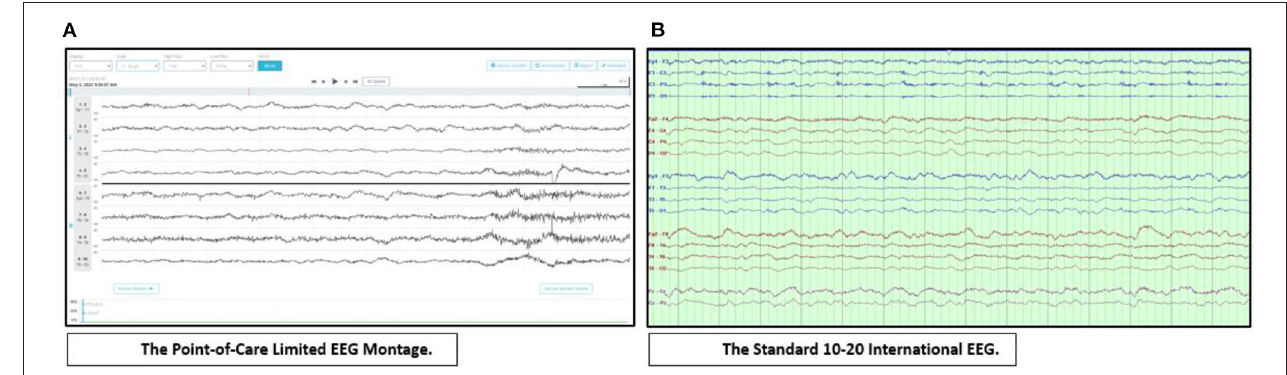
FIGURE 1 | Point-of-care EEG. Suspected seizures in a 62-year-old man with decreased level of consciousness ruled out within 10min with the use of a point-of-care limited EEG montage. The findings were later confirmed with the standard cEEG. (A) displays diffuse, irregular, attenuated mixed frequency delta-theta activity in the point-of-care limited EEG montage. Display: 10s, Scale: ± 50 µ V, High Pass: 1Hz, Low Pass: 70Hz, Notch: 60Hz. (B) displays diffuse, irregular, attenuated mixed frequency delta-theta activity in the standard International 10–20 EEG. Bipolar montage, LFF: 1Hz, HFF: 70Hz, Notch: 60Hz, Sensitivity: 7 µ V/mm, Timebase: 30 mm/s.